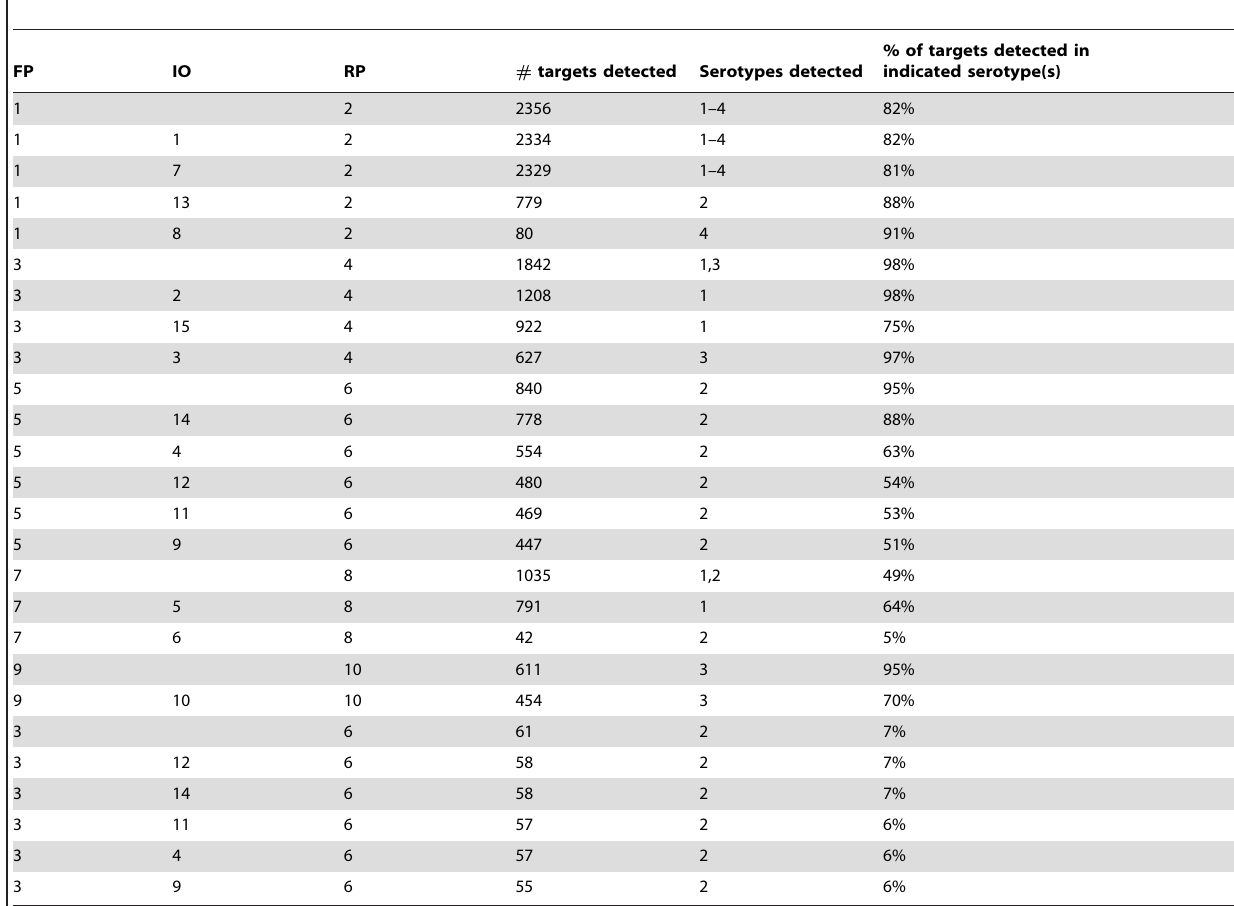
Table 6. Primer and probe combinations from Table 5, and number and serotypes of Dengue virus genomes detected by each primer/probe